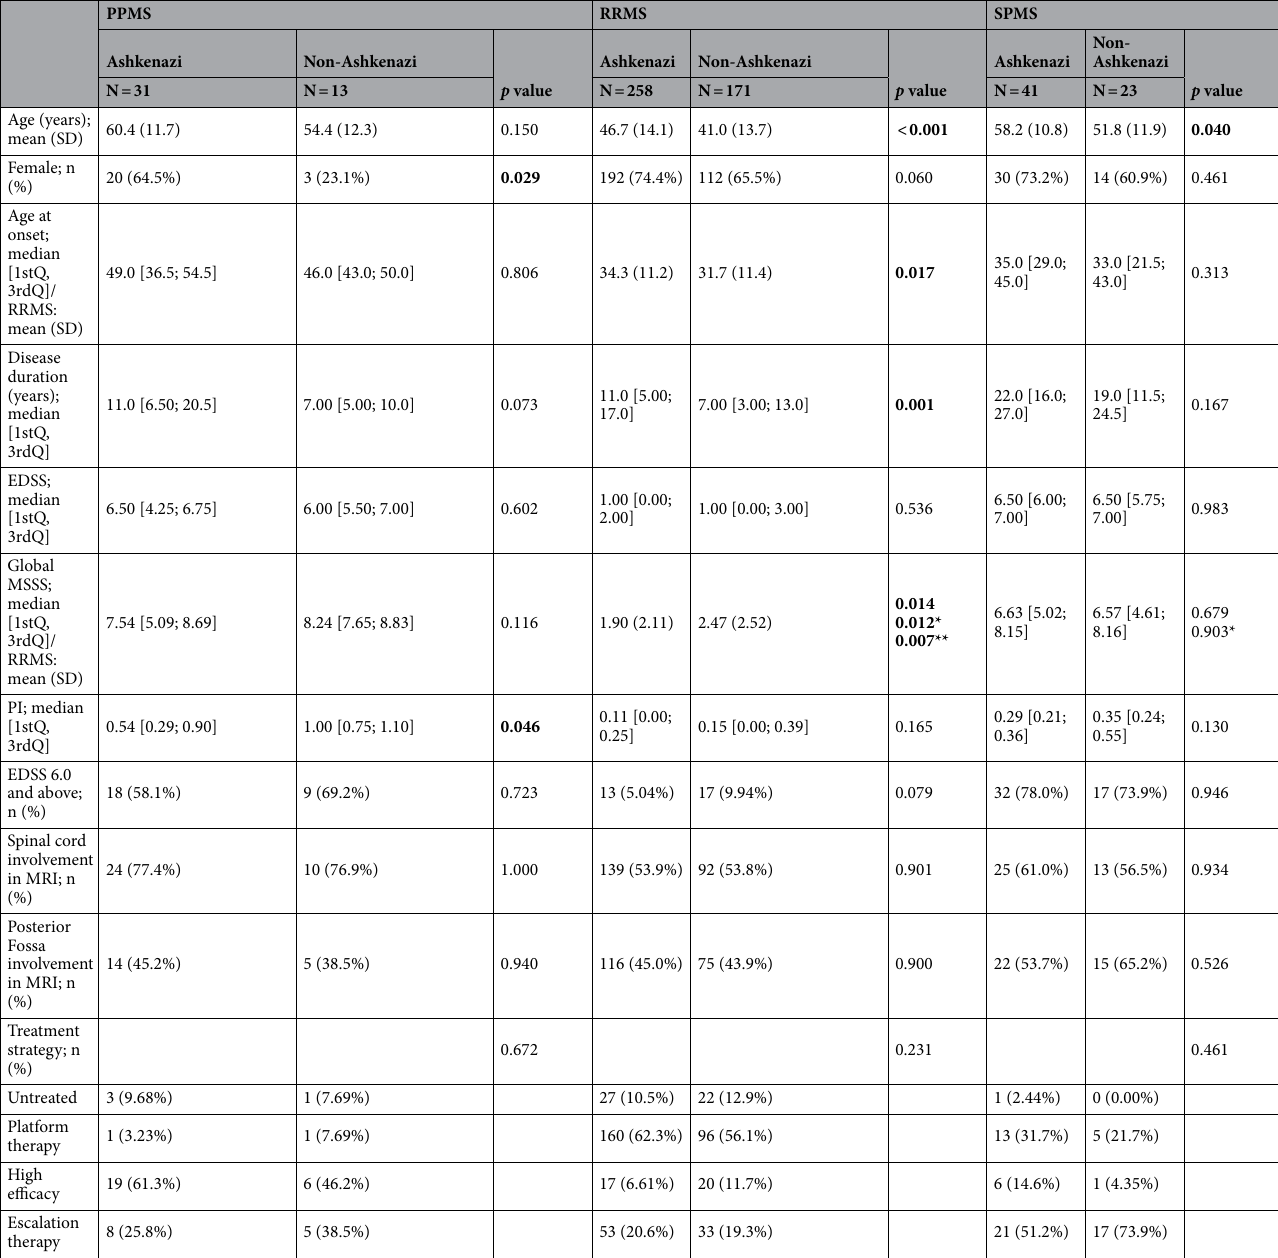
Table 3. Stratification by disease subtype. This table presents differences in disease phenotype between groups with stratification to disease subtype. Variables that were normally distributed according to Shapiro test ( p value < 0.05) are presented in the format of mean (SD) and compared using Student T-test. The MSSS in the RRMS subgroup was compared using student T-test as accepted for continuous scales in large samples. Non- normal variables are presented by median [1st quartile, 3rd quartile], and compared using Mann-Whitney U test. Categorial variables are compared using Chi-squared test and presented with count (%). p values in bold denote statistical significance (p < 0.05). p values marked by one asterisk (*) are controlled for age at EDSS, while those marked with 2 asterisks (**) are controlled for age at onset using ANCOVA. Normally distributed variables are compared using student T test and are presented with mean (SD), while non-normal variables are compared using Mann Whitney U test and are presented with median [1st quartile, 3rd quartile]. PPMS primary progressive multiple sclerosis, RRMS relapsing remitting multiple sclerosis, SPMS secondary progressive multiple sclerosis, EDSS Expended Disability Status Score; MSSS Multiple Sclerosis Severity Score, PI Progression Index, MRI magnetic resonance imaging. *Controlled for age at EDSS using ANCOVA. **Controlled for age at onset using